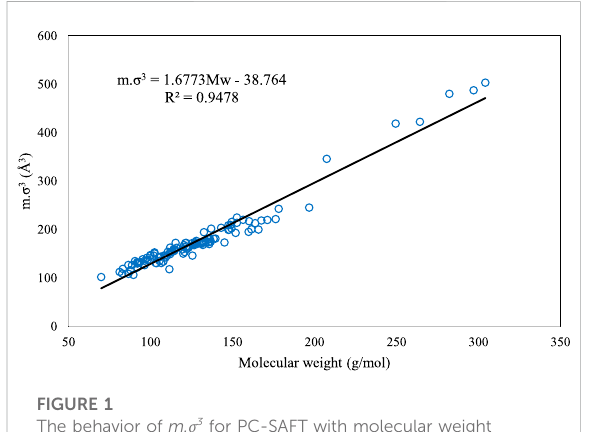
FIGURE 2 The behavior of m. σ 3 for PC-SAFT with molecular weight